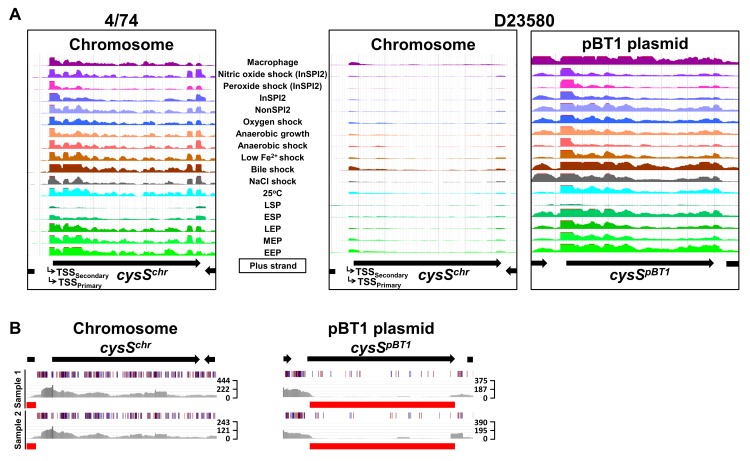
The pBT1 plasmid encodes the functional cysteinyl-tRNA synthetase in S. Typhimurium D23580.(A) RNA-seq data for cysS in 4/74 and chromosomal and pBT1-plasmid-encoded cysS in D23580 from the online JBrowse resources provided in this study. The scale of the mapped reads was 1 to 500. (B) Transposon library results for the cysSchr and cysSpBT1 genes in D23580. Figures were obtained using the Dalliance genome viewer [60]. Black arrows at the top represent genes. Each sample is represented by three tracks. The first track contains blue and red lines that correspond to transposon-insertion sites; red = orientation of the transposon is the same as the direction of the gene, blue = opposite direction. The second track shows raw data for the Illumina sequencing reads. The third track highlights in red those genes that were considered “required” for growth in that condition based on an insertion index. The insertion index was calculated for each gene as explained in [59,61], and genes with insertion index values <0.05 were considered as “required” for growth in the Lennox rich medium. The scale on the right represents sequence read coverage. EEP, early exponential phase; ESP, early stationary phase; InSPI2, SPI-2-inducing; LEP, late exponential phase; LSP, late stationary phase; MEP, middle exponential phase; NonSPI2, SPI-2-noninducing; RNA-seq, RNA sequencing; SPI, Salmonella pathogenicity island; tRNA, transfer RNA; TSS, transcriptional start site.